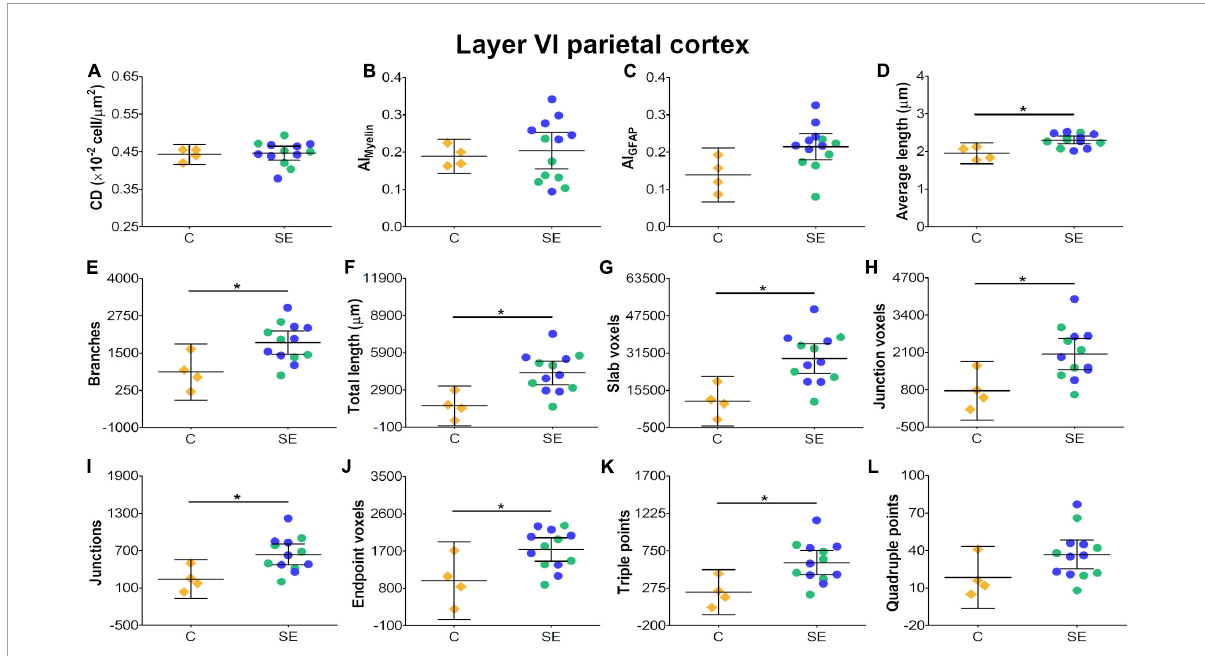
FIGURE6 Histological-derived parameters from automated cell counting analyses (A) , structure-tensor (ST)-based analyses of myelin (B) , and ST (C) and skeleton-based analysis (D–L) from GFAP-stained sections in layer VI of the parietal cortex. Notations as in Figure 4 . SE animals exhibited increases in average length (D) and in all skeleton-based parameters (E–L) as compared to controls (BH-FDR-corrected q -value * < 0.05; two-side permutation t -test). AI, anisotropy index; C, control; CD, cell density; SE, status epilepticus.